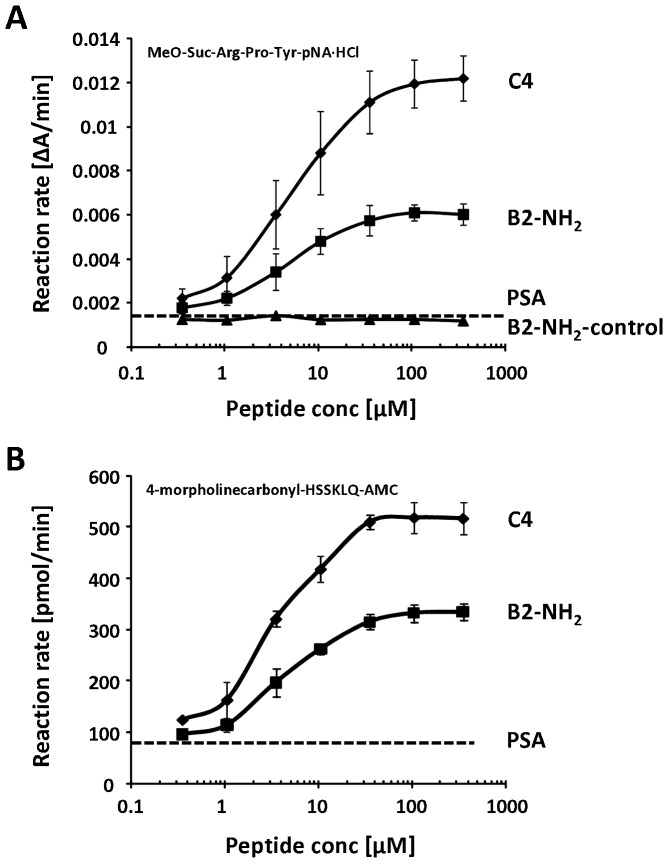
Peptides stimulate PSA activity towards small peptide substrates.Peptide C4 stimulated the activity of PSA (mean ± SD) more efficiently than peptide B2-NH2 towards (A) a chromogenic peptide substrate (n = 2) and (B) a fluorogenic peptide substrate (n = 3). Dashed lines indicate the activity of PSA without peptide stimulation.